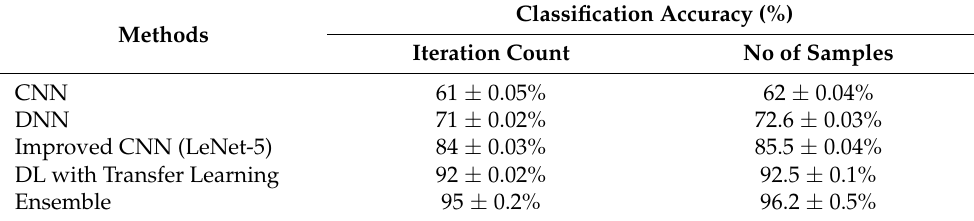
Table 3. Classification accuracy.